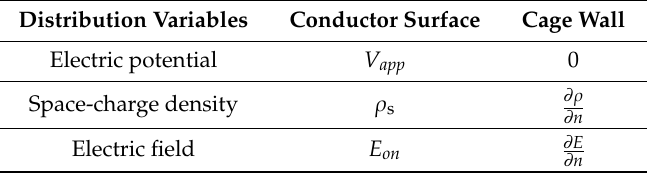
Table 1. Boundary conditions and initial